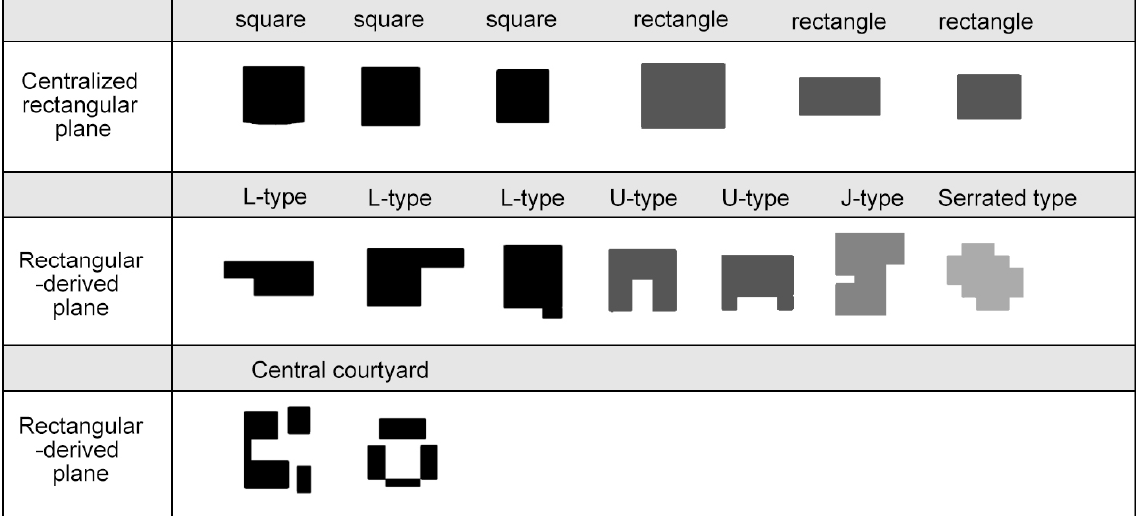
Figure 4. Building plane form.